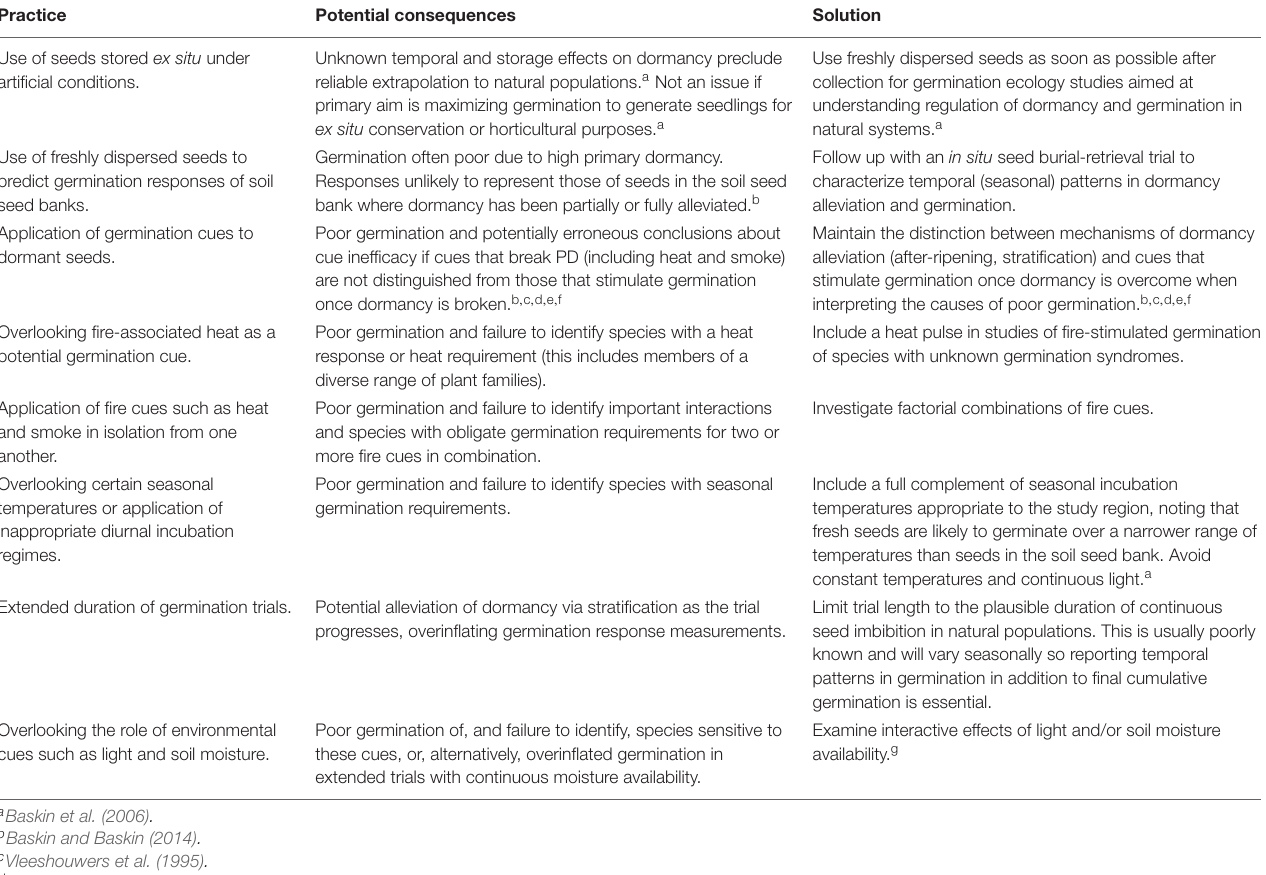
TABLE 1 | Common practices impeding our understanding of how dormancy and germination syndromes regulate post-fire emergence of species with physiological seed dormancy (PD) in fire-prone ecosystems and some practical solutions. Practice Potential consequences